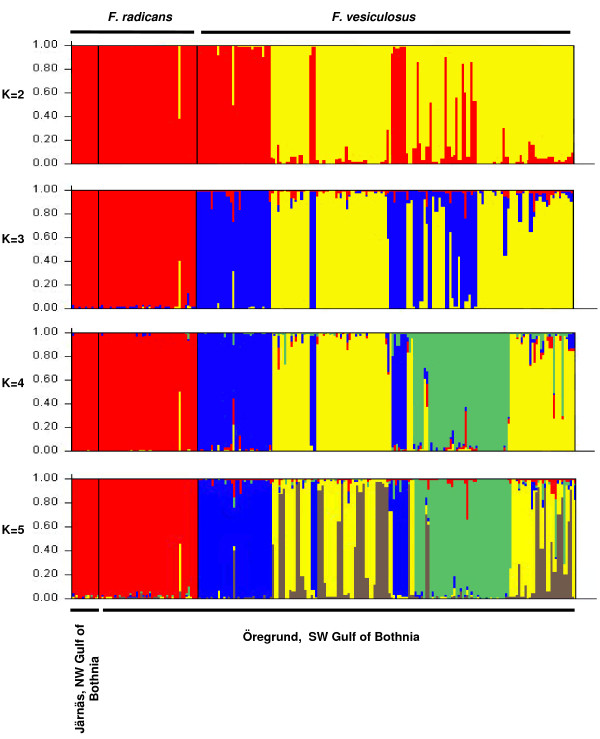
Histogram of Bayesian assignment tests. Analysis based on genotypes from individuals of F. radicans and F. vesiculosus exclusively from the Öregrund (SW Gulf of Bothnia) sampling sites, where both species occur in sympatry. Each bar represents an individual and its assignment probability into one of K clusters. Samples are without repeated genotypes assumed to be clones. More than one color per individual indicates admixture.